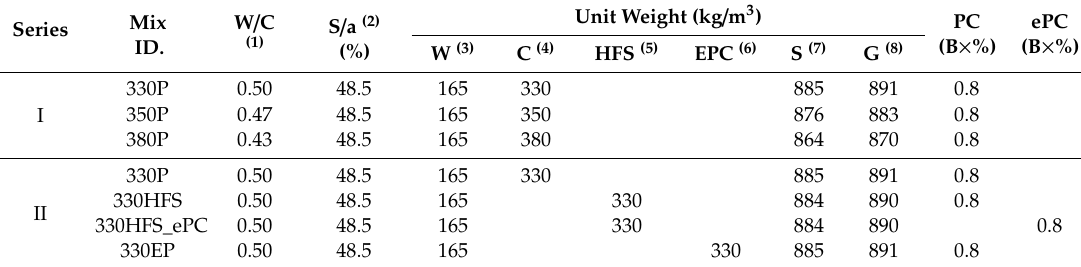
Table 3. Mixing proportions on